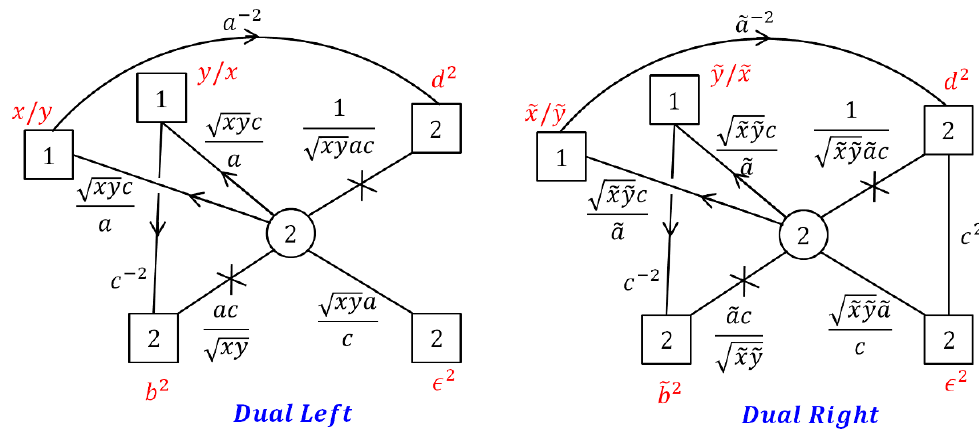
Figure 25 . The duals after the sequence of Seiberg dualities of the left and the right part. The two parts are glued identifying (cid:15) and d symmetries. Note that now (cid:15) symmetry is manifestly SU(2) while c is